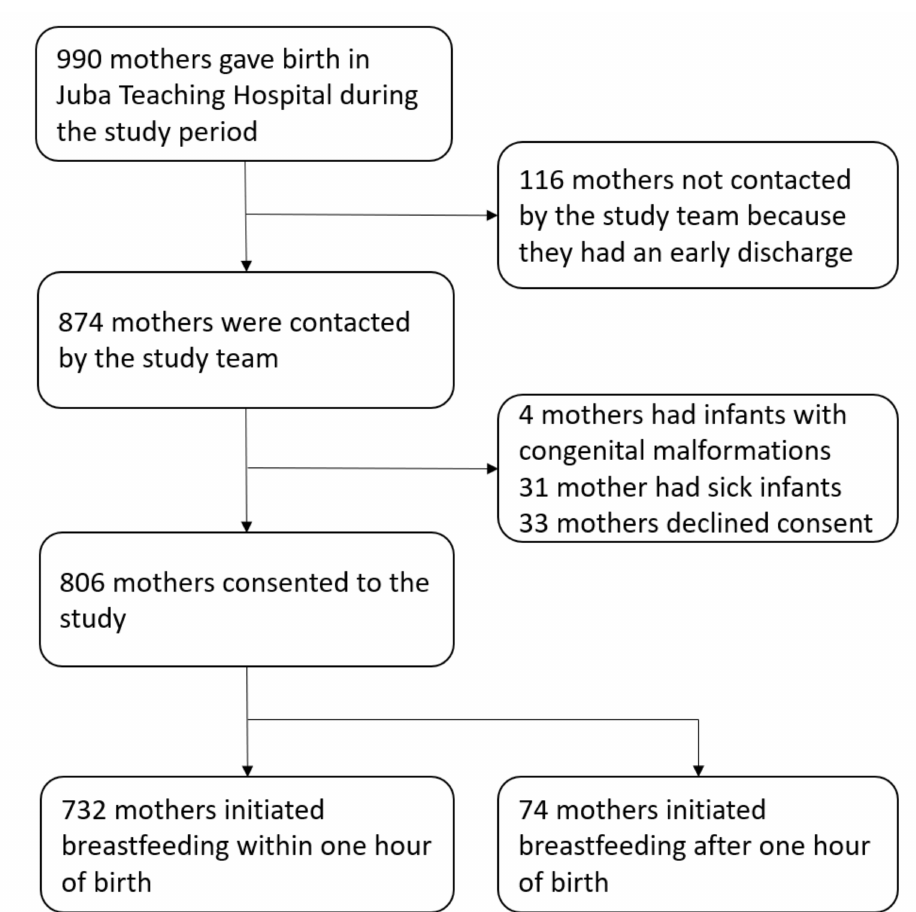
Figure 1. Profile of survey participants in April–July 2018 in Juba Teaching Hospital, South